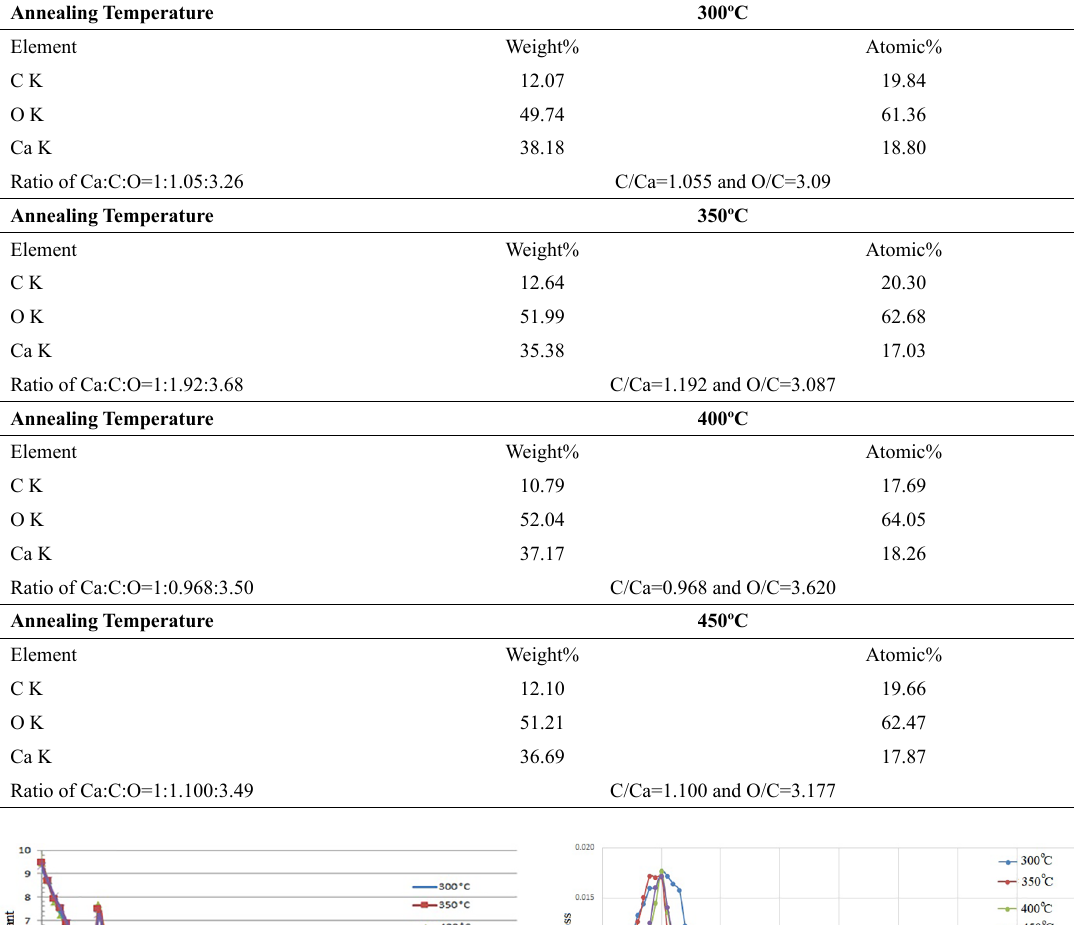
at different annealing temperatures 3